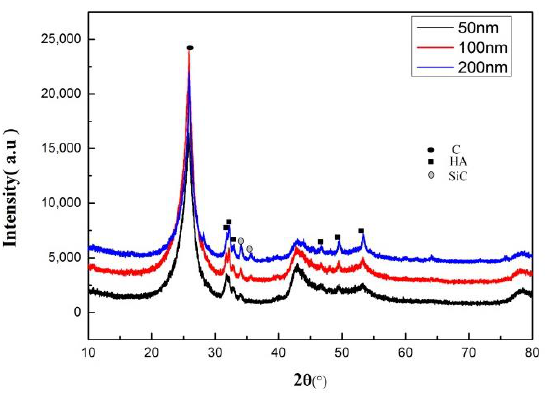
Figure 2. X-ray diffraction of SiC-hydroxyapatite coatings under different SiC particle sizes.